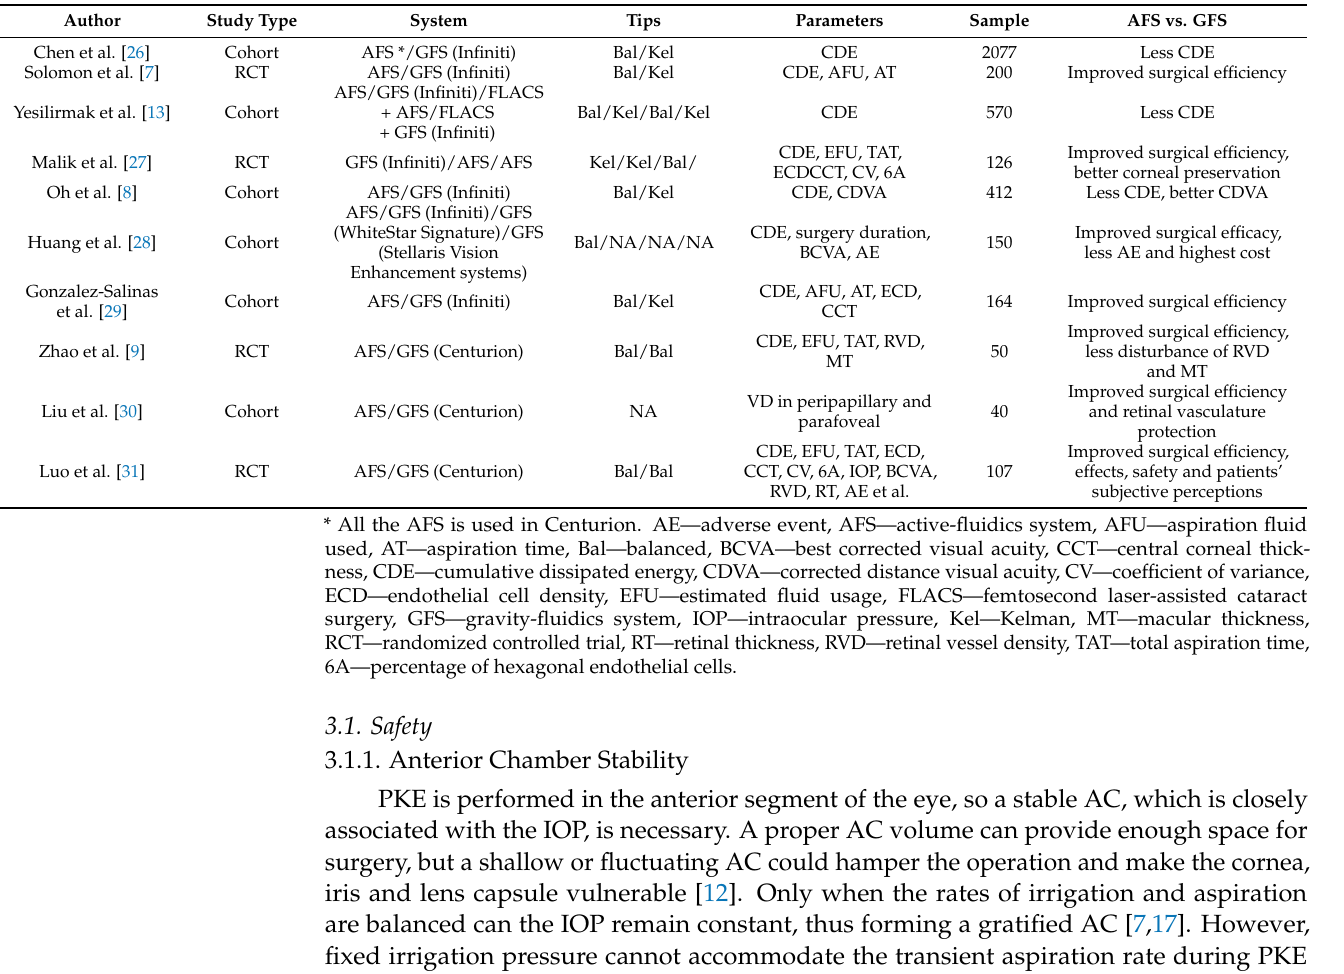
Table 1. Overview of main studies comparing AFS and